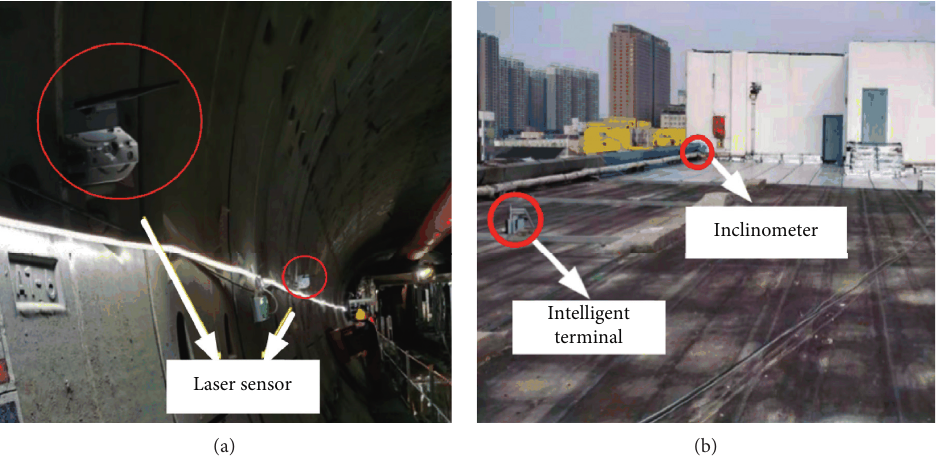
Figure 4: Layout of monitoring points on-site: (a) monitoring points for convergence of lining clearance and (b) monitoring points of adjacent buildings.